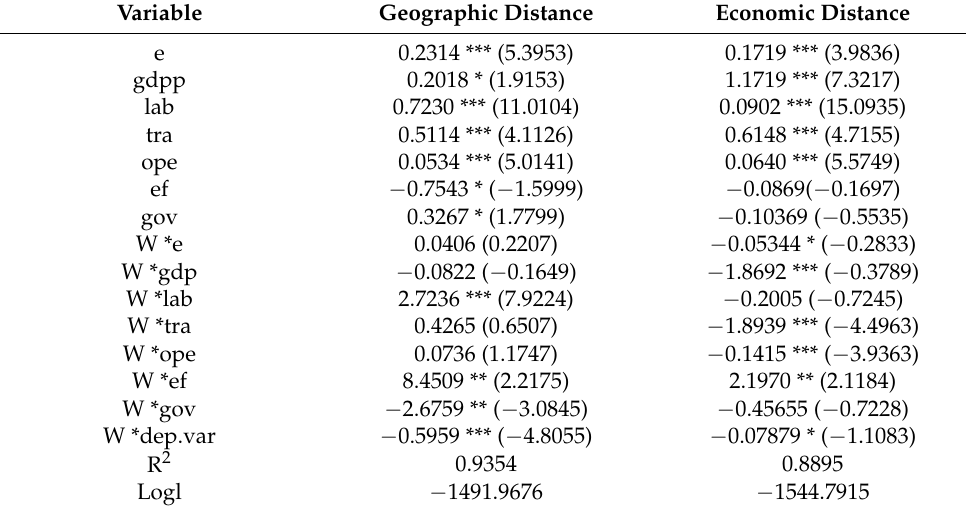
Table 4. Time fixed effect results of the SDM